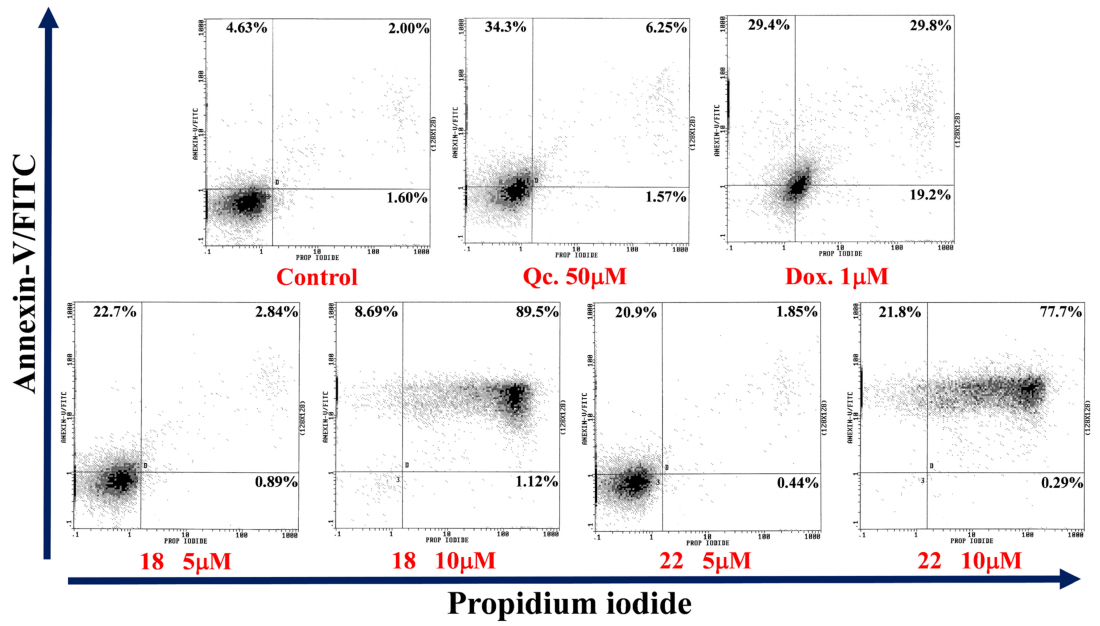
Figure 2. Effect of compounds 18 and 22 on apoptosis and necrosis of human K562 cell line assessed by flow cytometry. Early apoptosis was defined by annexin V-FITC brightness; necrosis expression by PI and late apoptosis by double positiveness. The double plots illustrate the effect of 24 h incubation with compounds 22 and 18 (5 and 10 µ M), QC: quercetin (50 µ M), Dox: doxorubicin (1 µ M), and